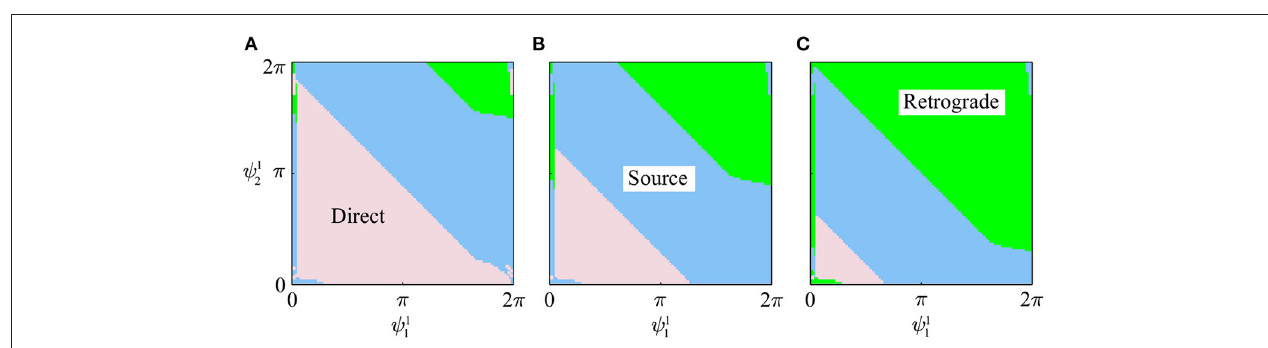
β ) π , (B) ψ 1 3 π , and (C) ψ 1 3 FIGURE 5 | Slices of basin of attraction for three gaits in simulation under three conditions: (A) ψ 1 3 2(1 2 βπ . = − = = This also appears as one line segment (to be precise, it the relative phase of the swing leg movement between comprises two line segments) in Figure 4 . Figure 6C shows Legs 2 and 3 can vary in the range indicated by the the footprint diagram for 9 1 [1.13 1.10 5.28] T (point violet arrow. = c in Figure 4 ). In this gait, the swing leg movement of Legs These three types of gaits were not predetermined, but 1 and 2 propagates from posterior to anterior, as shown emerged through the mechanical and sensory interaction. These by red arrows, while that of Legs 3 and 4 propagates from gaits are represented by line segments for 9 1 , which are serially anterior to posterior as shown by green arrows. However, connected as shown in Figure 4